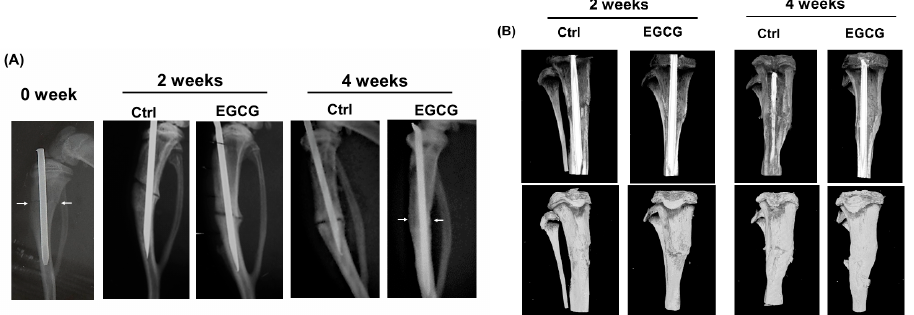
Figure 1. (-)-Epigallocatechin-3-gallate (EGCG) promotion of bone fracture healing in rats. The images of X-ray and micro-computed tomography ( µ -CT). ( A ) The X-ray radiographic analysis showed a clear fracture gap at weeks 0, 2, and 4 in the control group, and this fracture was gradually blurred at weeks 2 and 4 in the EGCG treated group. Arrows indicate the fracture site. ( B ) The results of µ -CT analysis also showed a gradual union of fracture gap at the end of weeks 2 and 4 after treatment. Compared to the control group, the fracture was united at the end of week 4 after the EGCG treatment, suggesting that fracture healing process was accelerated by EGCG. Table 1. The quantification results of callus in µ-CT.